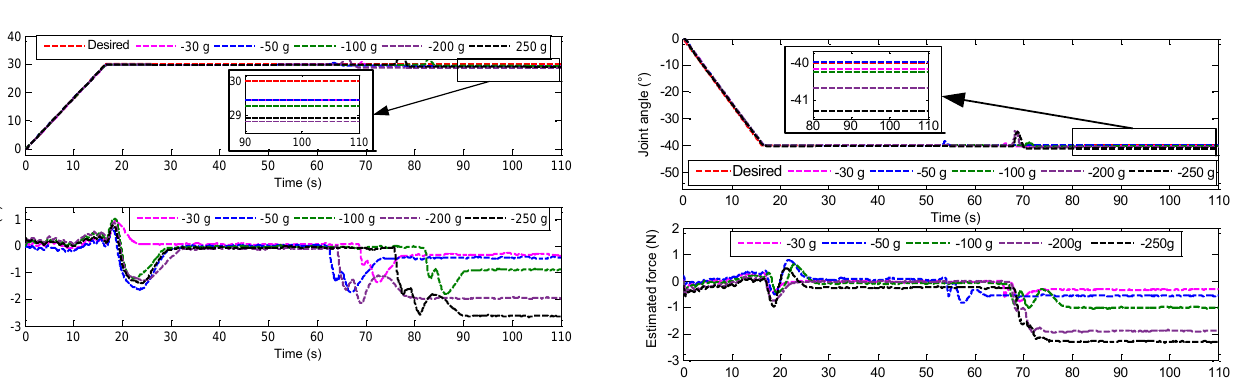
Figure 23. Negative direction loading experiment results at 30 ◦ .